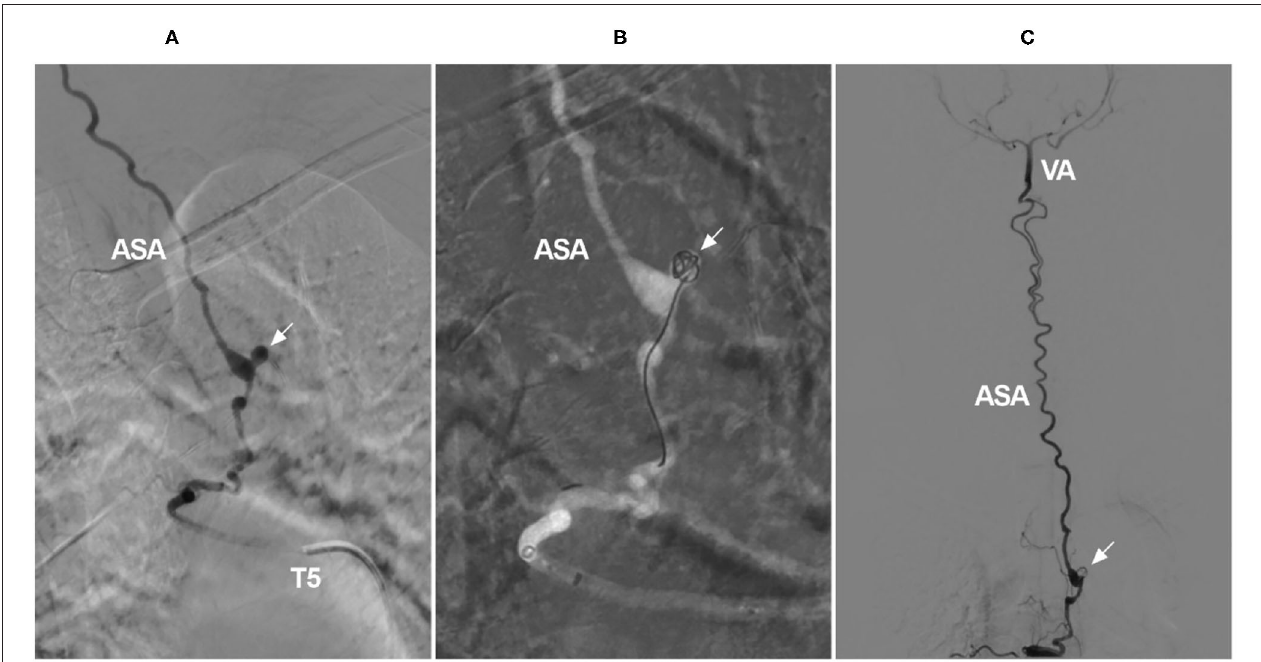
FIGURE 11 | Coiling of a ruptured aneurysm on the ASA as a collateral channel. (A) Angiogram of the T5 intercostal artery showing an aneurysm on the ASA (arrow), the ASA served as an upward collateral channel. (B) Under the roadmap, the aneurysm was coiled (arrow). (C) Overview of the angiogram showing that the aneurysm was coiled (arrow) and that the ASA was connected to the intracranial VA. ASA, anterior spinal artery; T, thoracic; VA, vertebral artery.